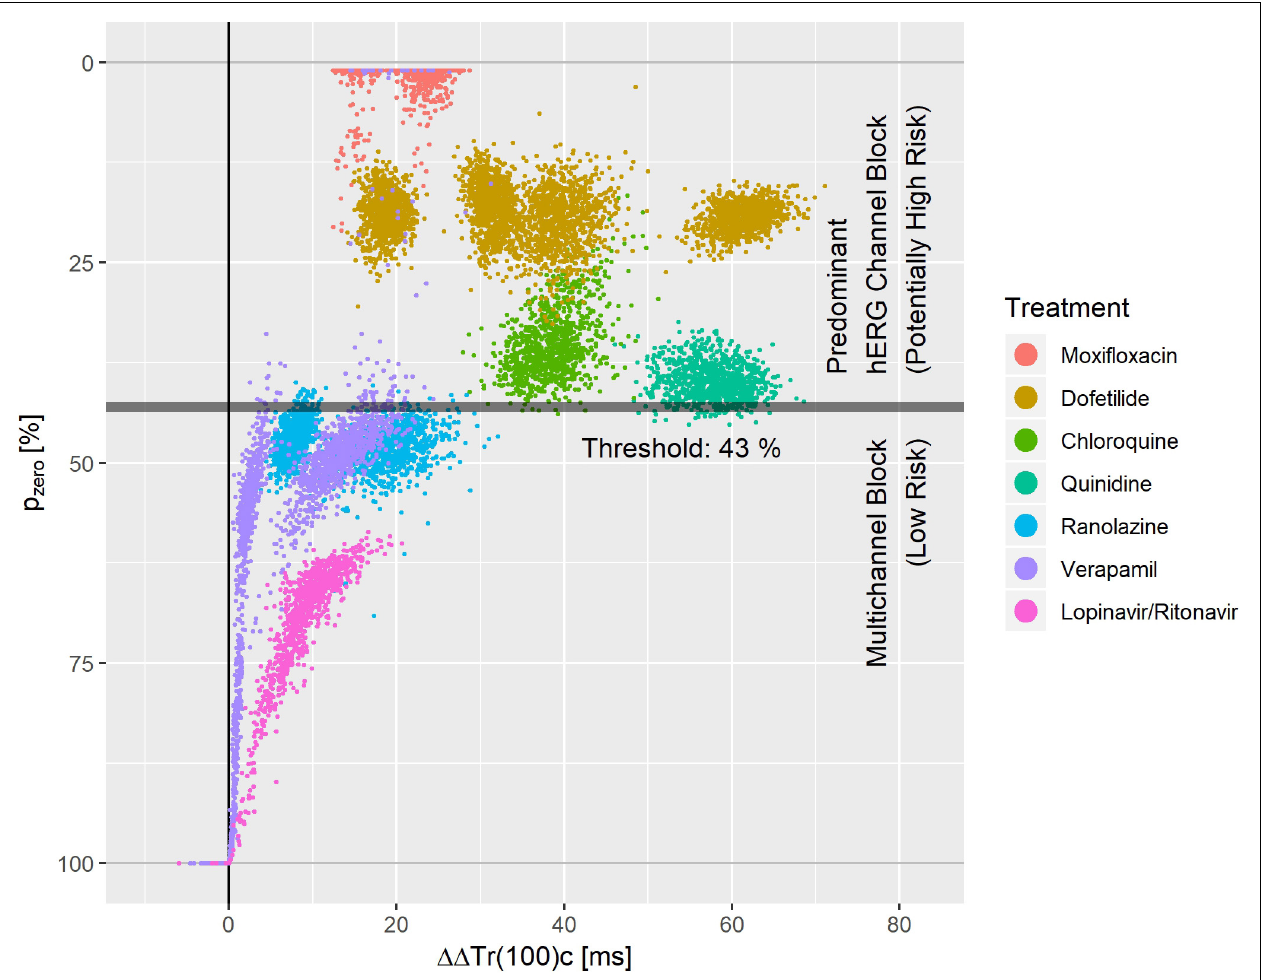
FIGURE 8 | Bootstrap simulated common distribution of p zero (the effect profile’s zero-transition percentage p) and (cid:49)(cid:49) Tr(100)c (the drug-induced the J-T end prolongation) for predominant hERG channel blocking drugs with potentially higher proarrhythmic risk and multichannel blocking drugs with low proarrhythmic